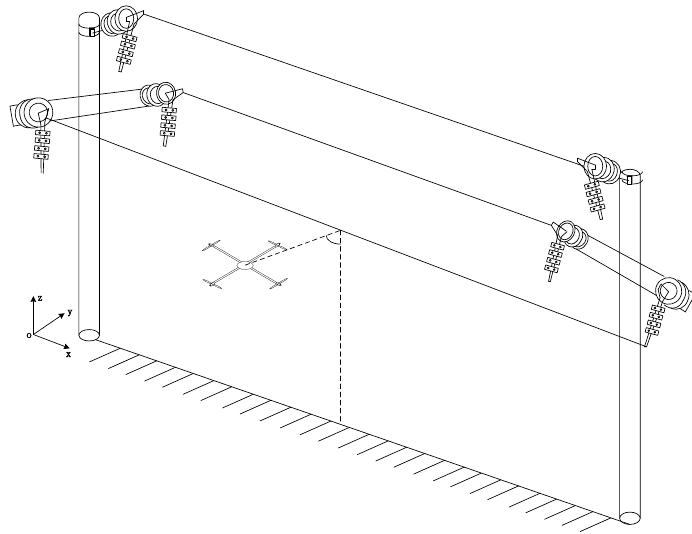
Figure 1. UAV patrol